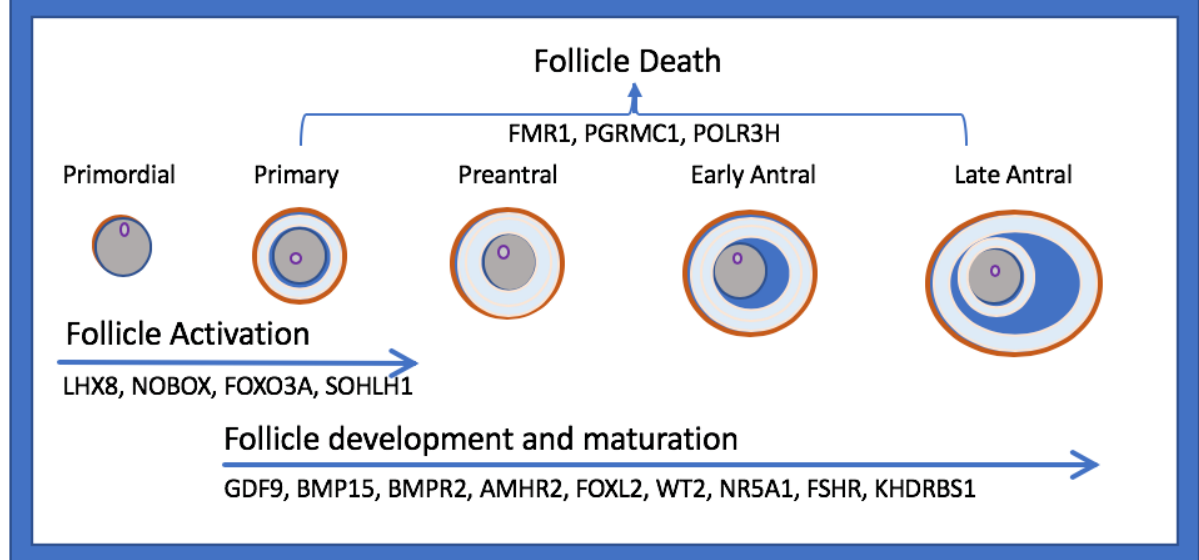
Figure 1. Selected genes involved in ovarian follicle activation, maturation, and death. AMHR2 , anti-Müllerian hormone receptor 2; BMP15 , bone morphogenic protein 15; BMPR2 , bone morphogenetic protein receptor 2; FMR1 , fragile X mental retardation; FSHR , follicle-stimulating hormone receptor; FOXO3A , forkhead box O3; FOXL2 , forkhead box L2; GDF9 , growth differentiation factor 9; KHDRBS1 , heteronuclear ribonucleoprotein particle K homology domain RNA binding S1; LHX8 , LIM homeobox 8; NOBOX , newborn ovary homeobox; NR5A1 , nuclear receptor subfamily 5 group A member 1; PGRMC1 , progesterone receptor membrane component 1; POLR3H , RNA polymerase III subunit H; SOHLH1 , spermatogenesis and oogenesis specific basic helix–loop–helix 1.